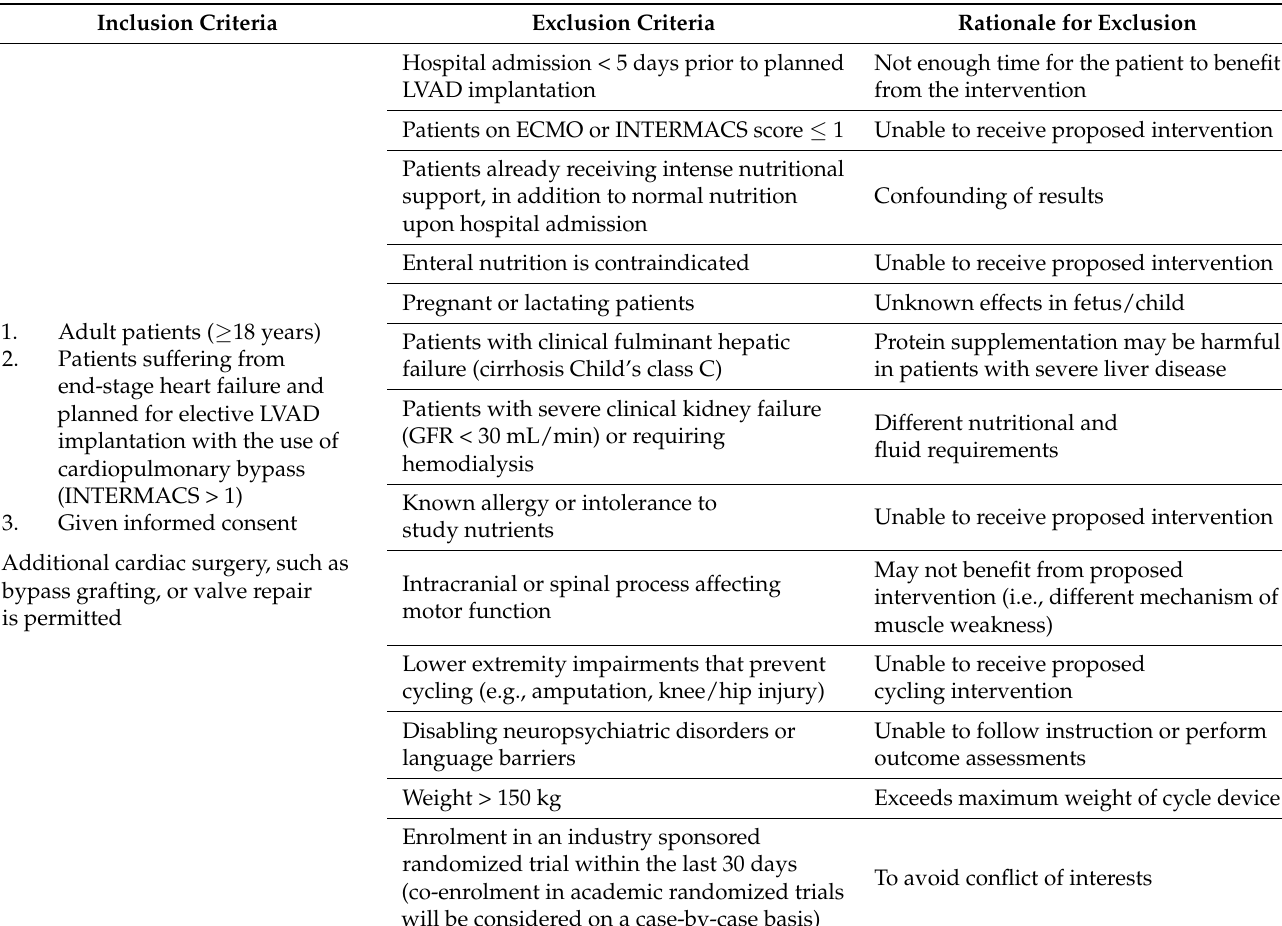
Table 3. In- and exclusion criteria of the PROPER-LVAD study. Abbreviations: ECMO: extracorporeal membrane oxygenation, GFR: glomerular filtration rate, INTERMACS: Interagency Registry